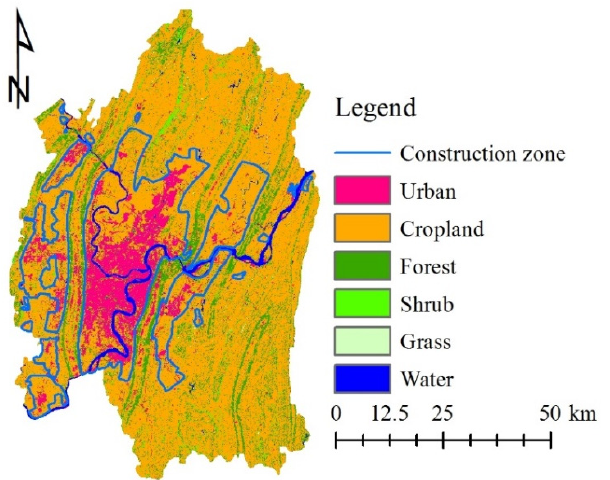
Figure 5. Digitized construction zone from the development plan designed for 2007 to 2020 (LULC 2010 as background).